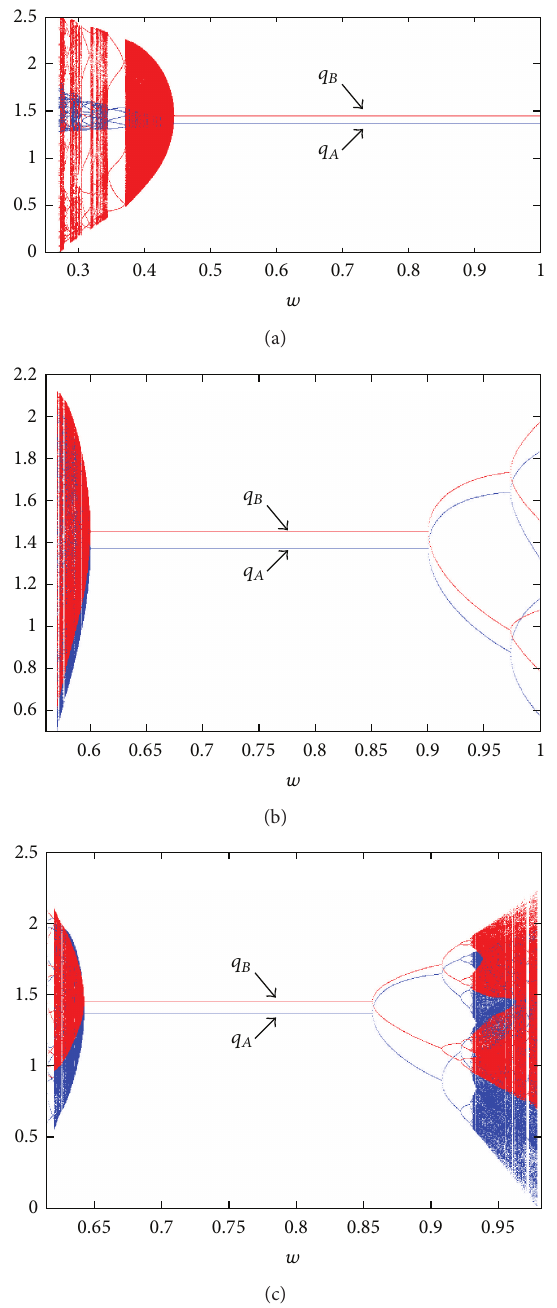
Figure 5: Bifurcation diagrams of dynamic system (10) with the weight coefficient assigned 𝑤 .